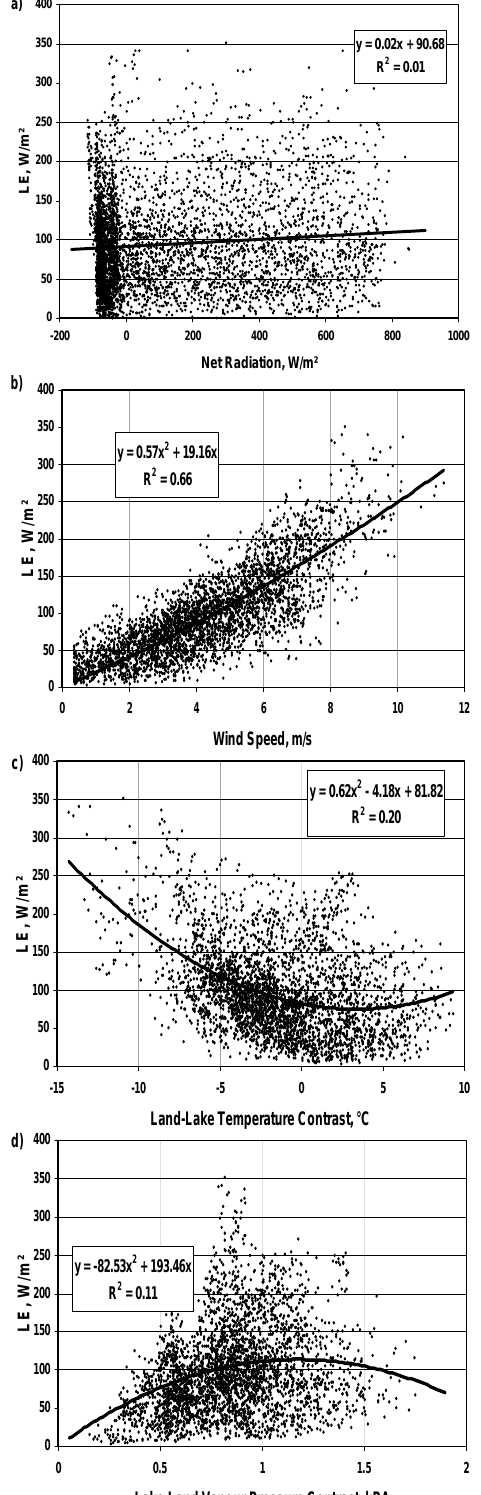
Figure 2. The observed relationship between the hourly evaporation over Crean Lake, 2006, and (a) net radiation, (b) wind speed, (c) land-lake temperature contrast, and (d) lake-land vapour pressure contrast.